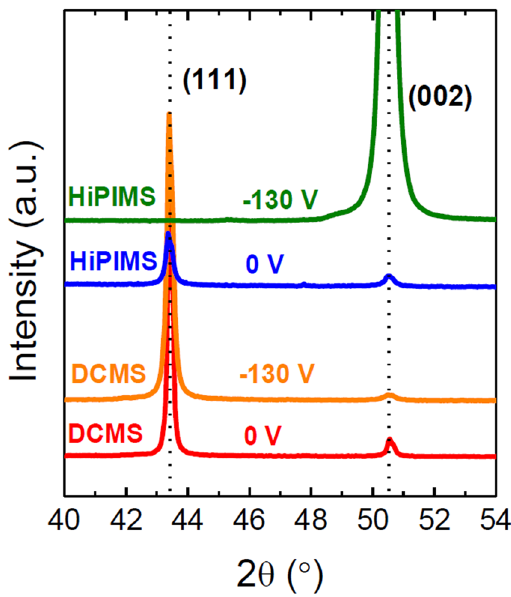
Figure 1. Effect of bias voltage on the film crystal structure. XRD θ –2 θ scans for grounded (0 V) and − 130 V bias DCMS and HiPIMS Cu films (~150 nm